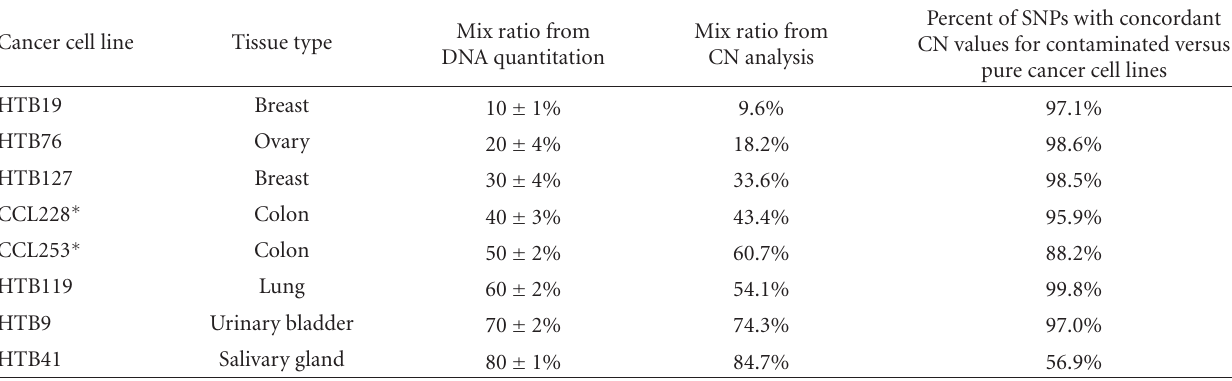
Table 5: Comparison of the degree of contamination of cancer cell lines with CEPH cell line NA12776 determined using the picogreen quantitation (averaged over three measurements) and the algorithm presented in this